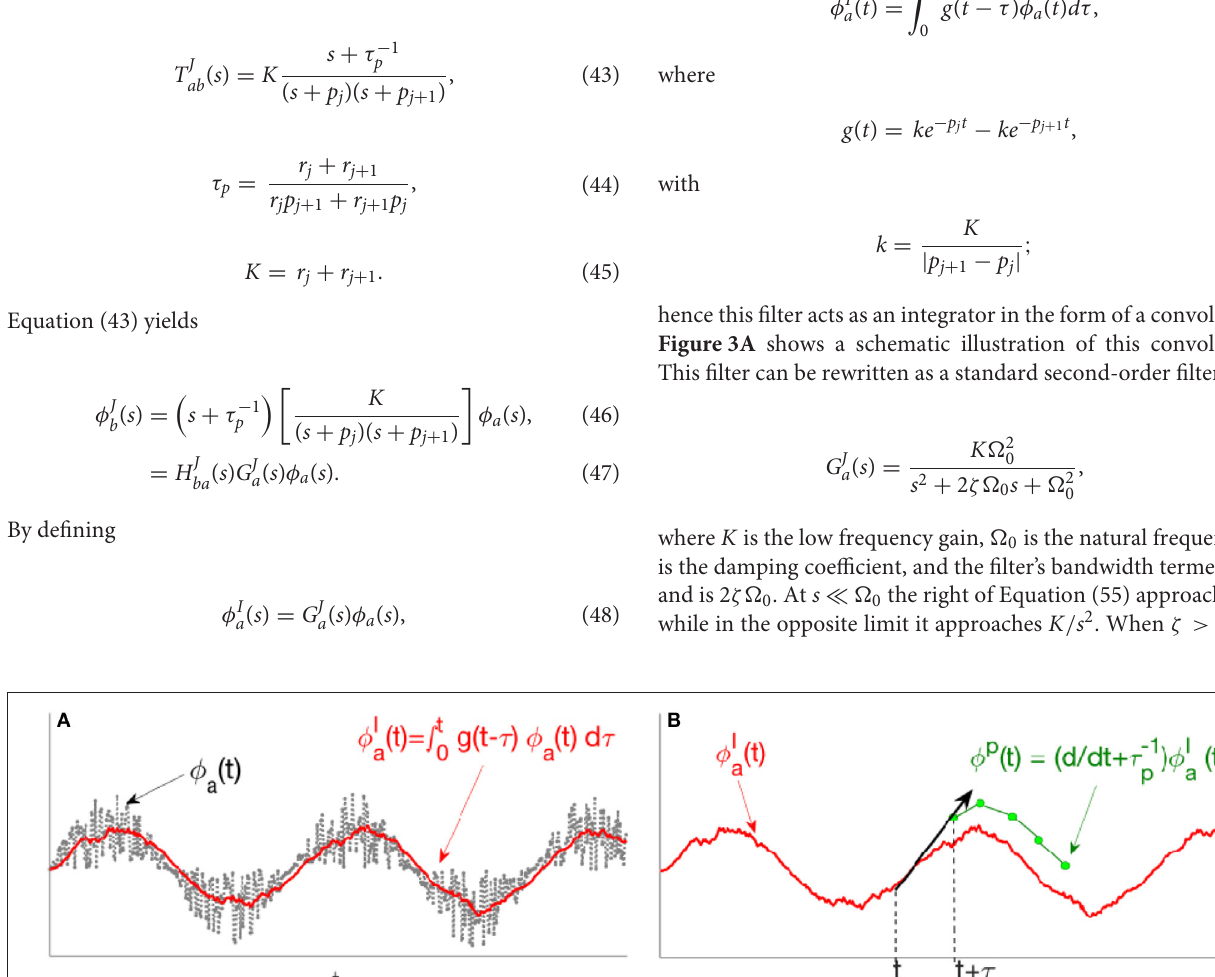
Frontiers in Human Neuroscience |